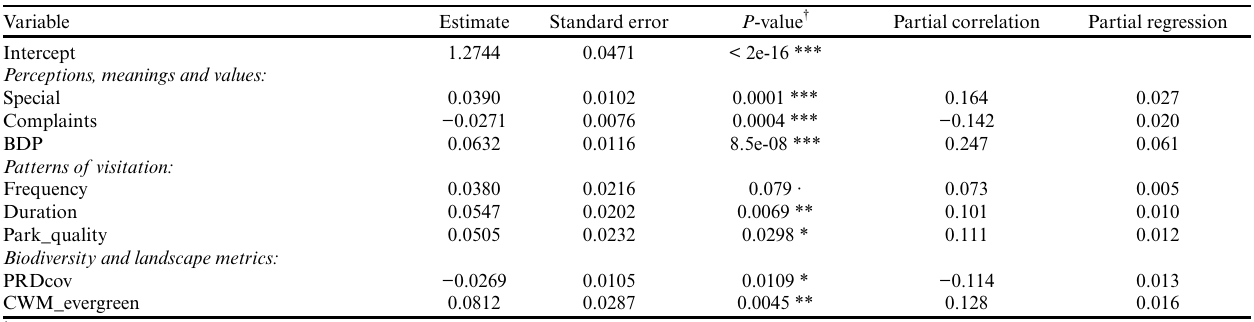
Table 4. Generalized linear model for perceived restorativeness (scaled variables). BDP = biodiversity perception, PRDcov = patch richness density of cover types, CWM_evergreen = community weighted mean of evergreen